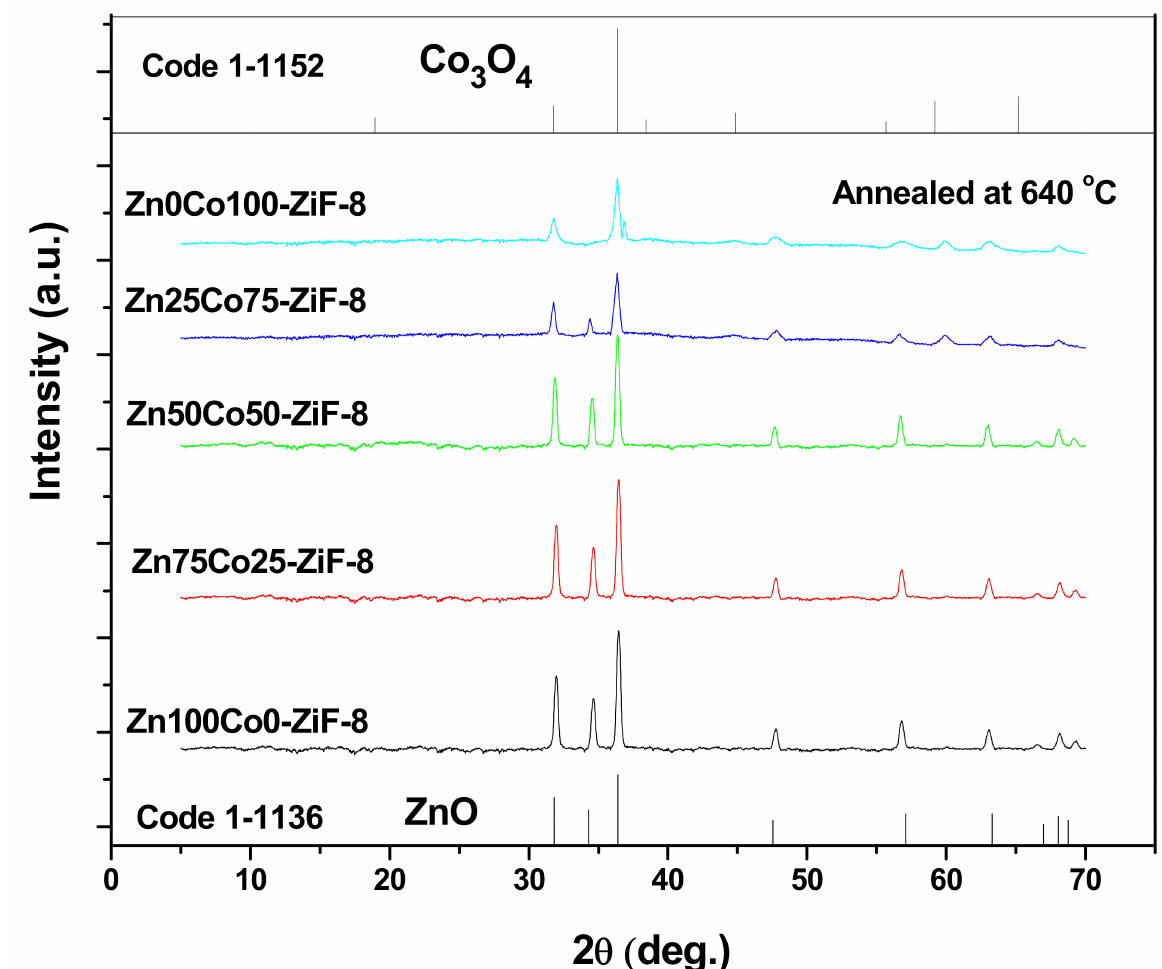
Figure 7. The XRD pattern of different compositions of Zn x Co 1-x -ZIF-8 after annealing at 640 ◦